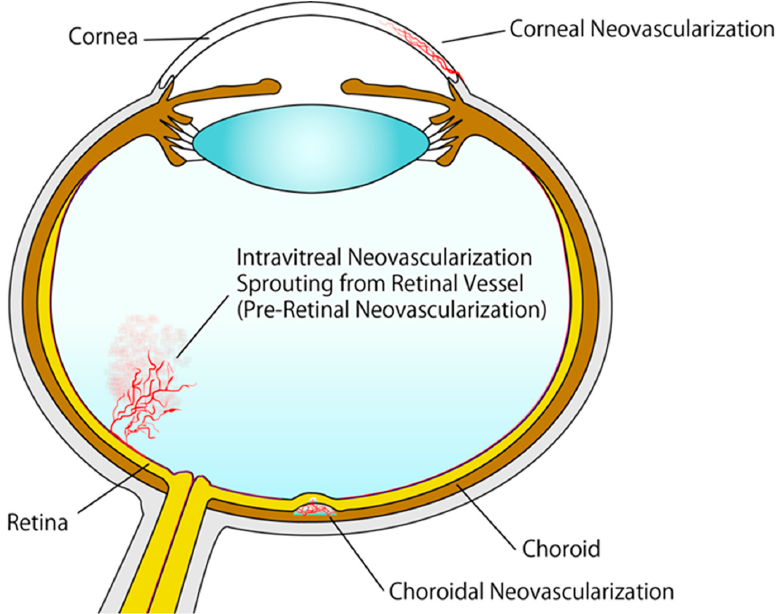
Figure 1. Schematic representation of ocular neovascularization.